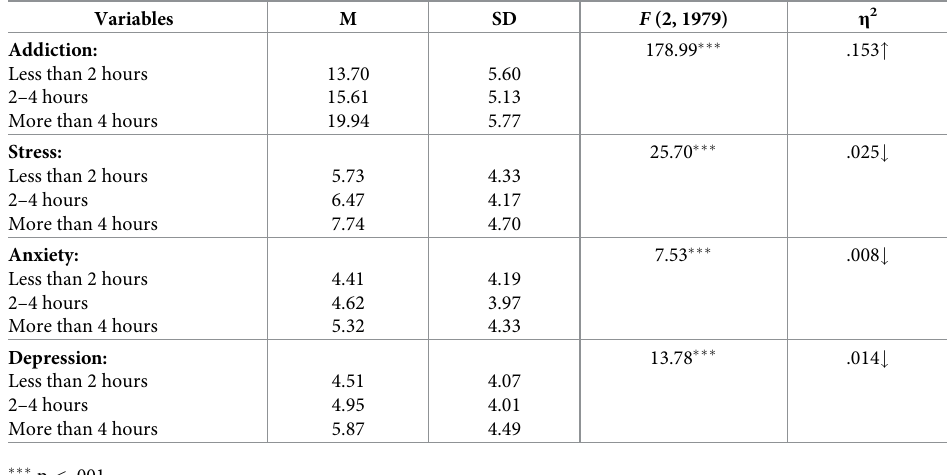
Table 2. Means, SDs, and ANOVA for the variables according to the total hours of SD use per day. Variables